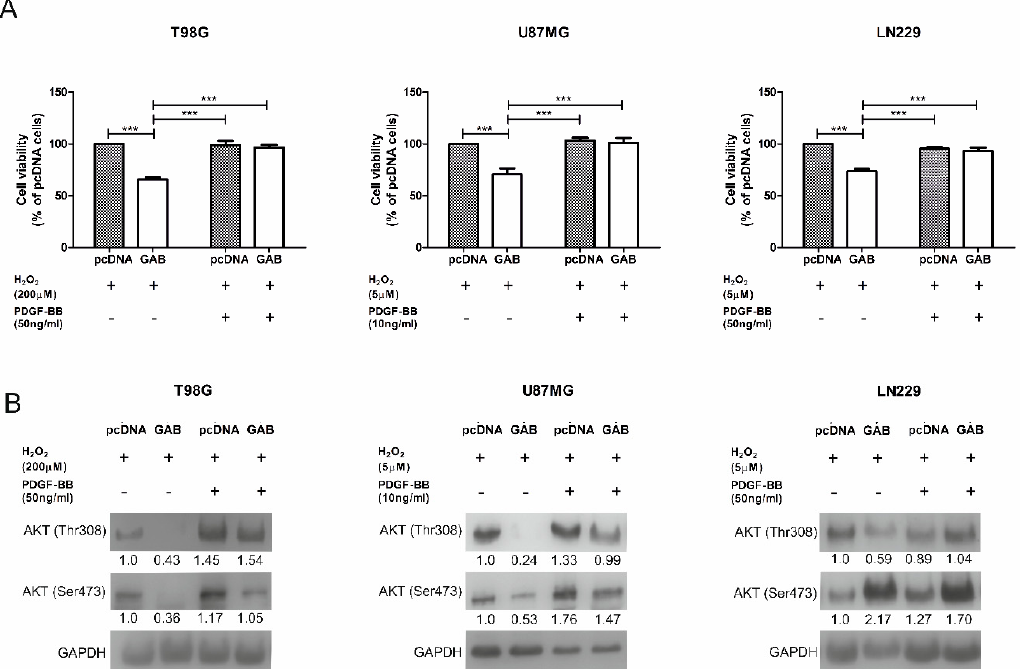
Figure 7. Pretreatment with PDGF-BB, an AKT pathway activator, restores the resistance to H 2 O 2 treatment. ( A ) (i) The viability of T98G cells transfected with an empty pcDNA or carrying the GAB sequence vector cultured in media with or without PDGF-BB (50 ng/mL) for 24 h before exposure to H 2 O 2 (200 µM, 15 min); (ii) the viability of U87MG cells transfected with an empty pcDNA or carrying the GAB sequence vector cultured in media with or without PDGF-BB (10 ng/mL) for 24 h before exposure to H 2 O 2 (5 µM, 15 min); and (iii) the viability of LN229 cells transfected with an empty pcDNA or carrying the GAB sequence vector cultured in media with or without PDGF-BB (50 ng/mL) for 24 h before exposure to H 2 O 2 (5 µM, 15 min). Cell viability was determined by an MTT assay, and the results are expressed as a percentage of cells transfected with an empty pcDNA vector non-pretreated with PDGF-BB. Results are mean ± SD ( n = 4–5). *** p < 0.001 (one-way ANOVA followed by Tukey’s test). ( B ) An influence of PDGF-BB treatment on the level of AKT (Thr308) and AKT (Ser473) in T98G, U87MG, and LN229 cell lines was analyzed by a western blot. Results are mean ±